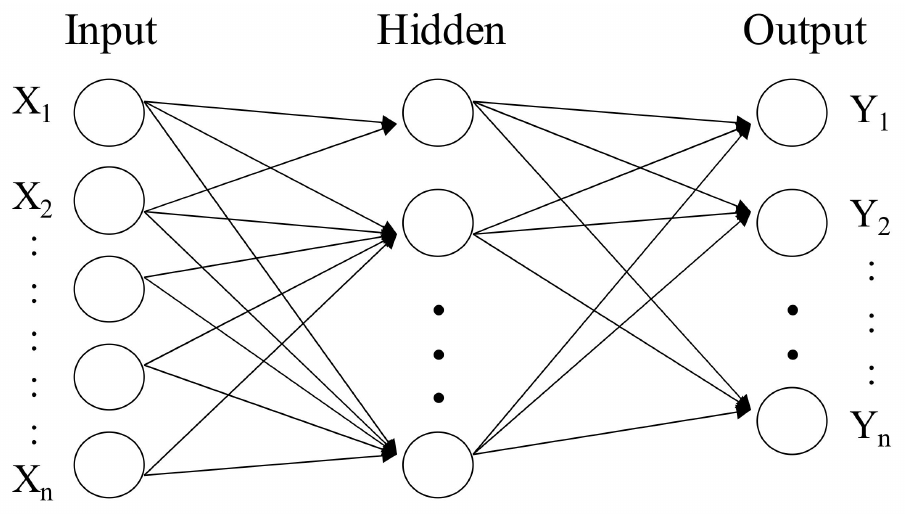
Figure 6. The structure of a three-layered neural